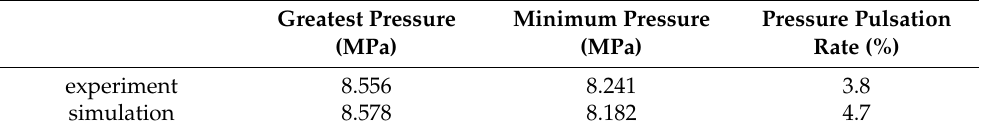
Table 7. Comparative analysis of the fluid pressure fluctuation value and pressure fluctuation rate.